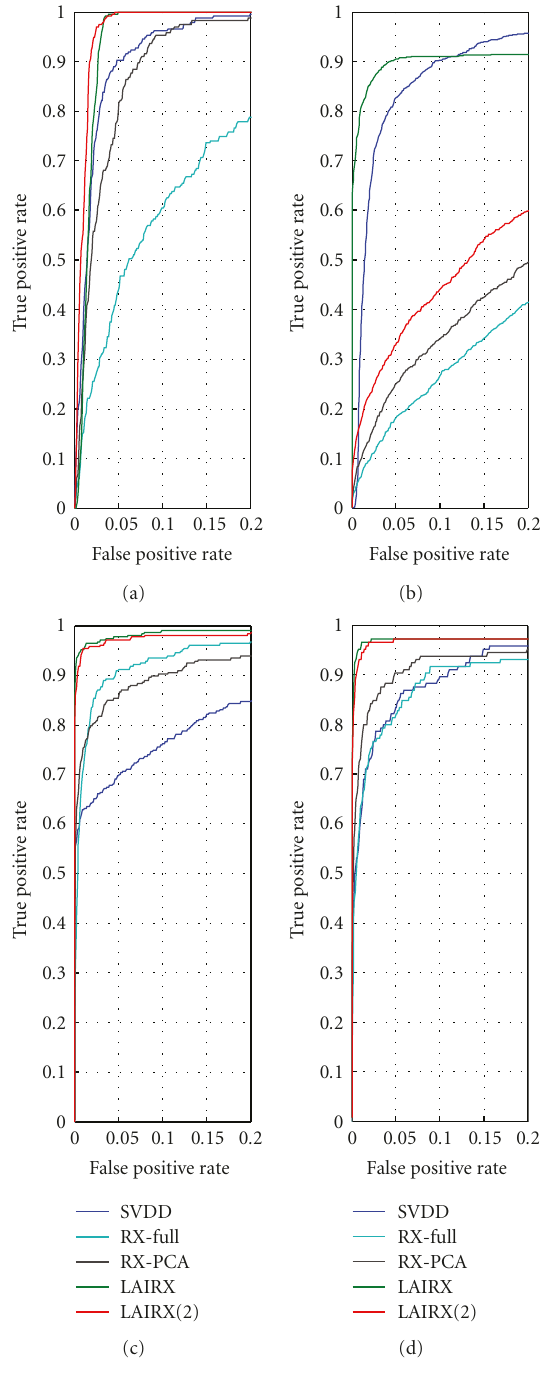
Figure 7: Receiver Operating Characteristic (ROC) curves for each image. (a) ARES1D, (b) ARES1F, (c) ARES2F, (d) ARES3F.